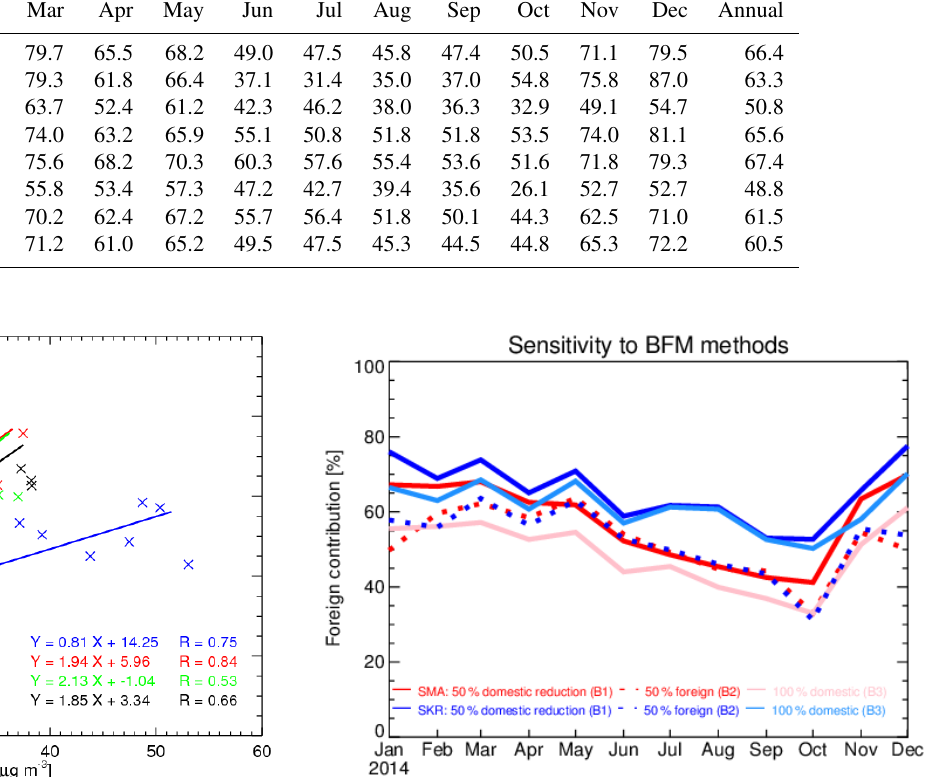
Figure 11. Seasonal variations in foreign emissions contributions to surface PM 10 concentrations over the SMA (red, dashed red, and pink lines) and over South Korea (blue, dashed blue, and light blue lines). Simulation cases B1–B3 indicate the choice of BFMs as de- scribed in Table